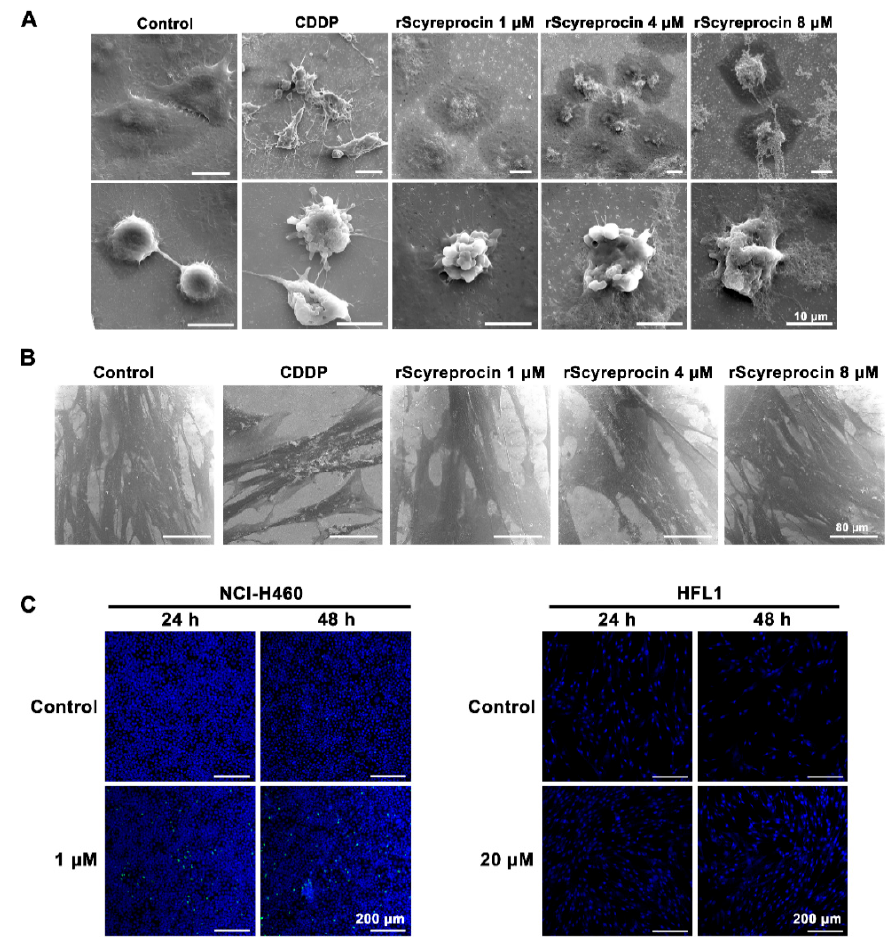
Figure 3. Recombinant scyreprocin (rScyreprocin) induced apoptosis and cell membrane destruc- tion of H460 cells but not HFL1 cells. ( A ) Effect of rScyreprocin on H460 cell morphology. Cells were treated with rScyreprocin (0, 1, 4, and 8 µ M) or cisplatin (CDDP) for 24 h and observed for morphological changes by a scanning electron microscope (SEM) (scale bar = 10 µ m). ( B ) Effect of rScyreprocin on HFL1 cell morphology. HFL1 cells were incubated with rScyreprocin (0, 1, 4, and 8 µ M) or CDDP (32 µ M) for 24 h and observed by a scanning electron microscopy (scale bar = 80 µ m). ( C ) Apoptotic effect of rScyreprocin on H460 and HFL1 cells. Cells were incubated with rScyreprocin and evaluated for apoptosis using TUNEL staining. Nuclei were visualized by DAPI staining (blue); a positive signal (green) indicating apoptosis was detected in rScyreprocin-treated H460 cells but not in HFL1 cells (scale bar = 200 µ